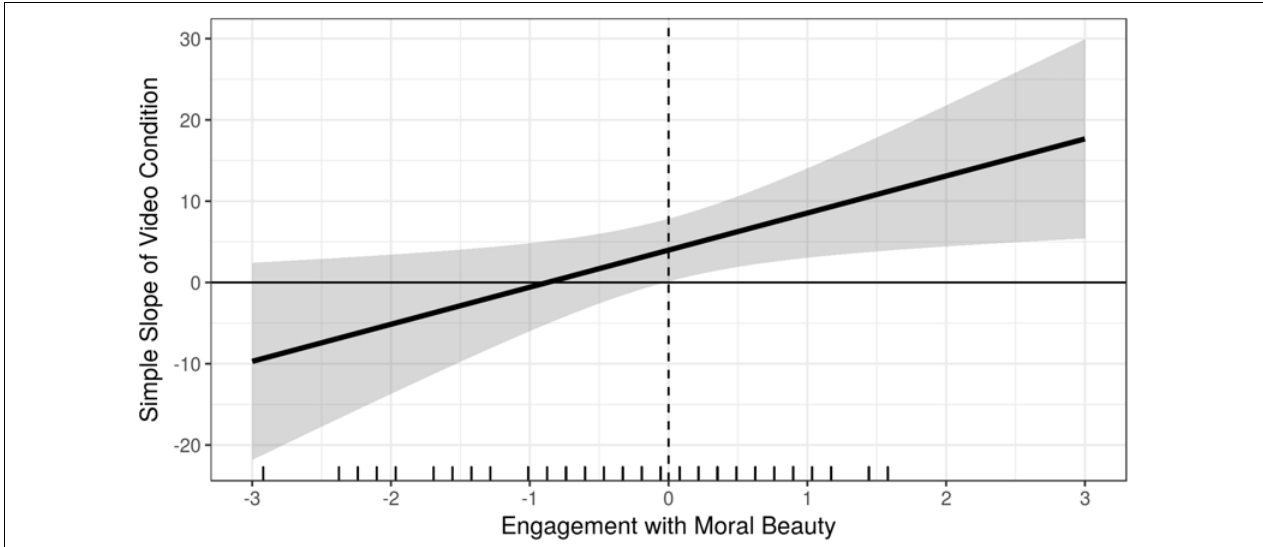
FIGURE 4 | Marginal effects (or regions-of-significance) plot: On the y -axis we depicted the simple slope of video condition on dictator game generosity. On the x -axis we z -transformed Engagement with moral beauty for the purpose of this figure. The simple slope is significant and positive when Engagement with moral beauty is above-average. 40.68% of observations in Engagement with moral beauty are within this region. The results depicted are those using the trimmed sample, N = 85.